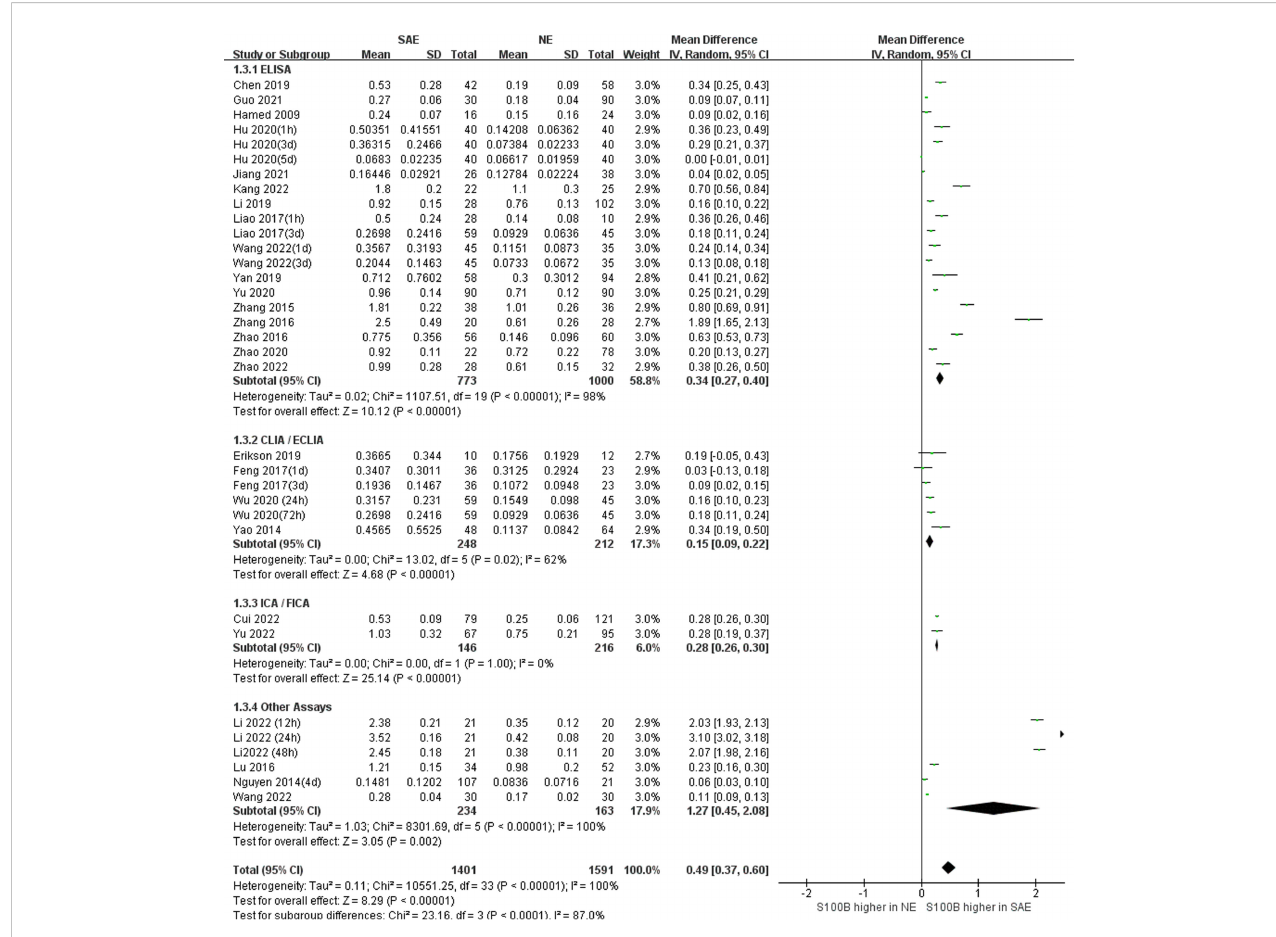
FIGURE 7 Meta-Analysis forest plot: association between serum S100B level and patients with SAE in different measure